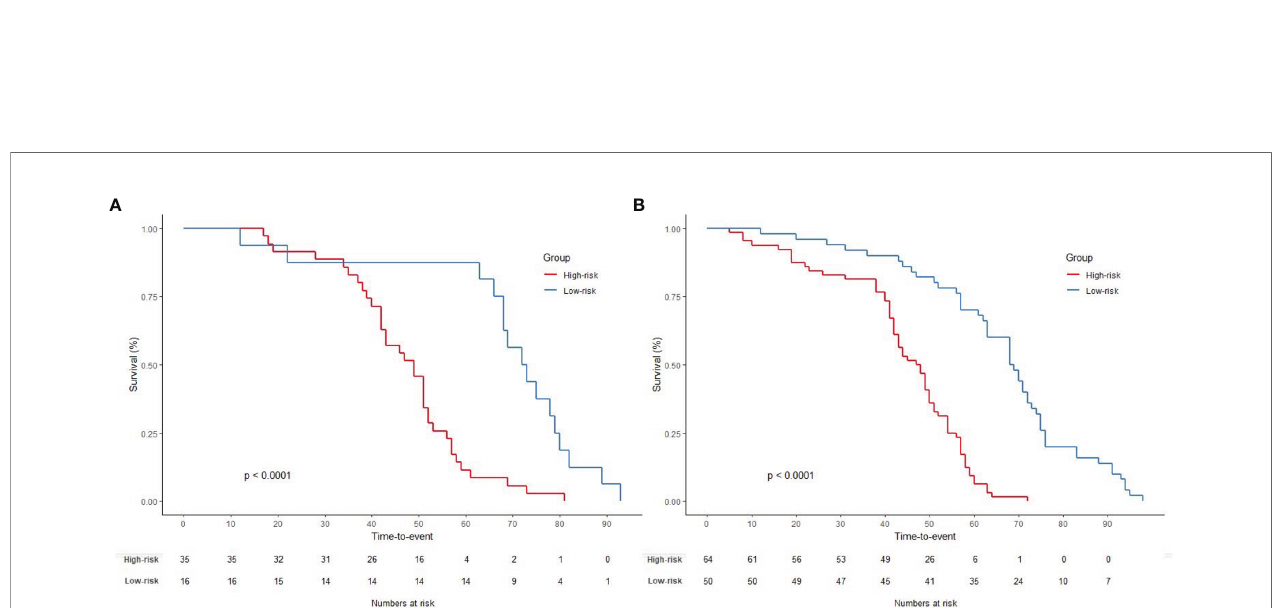
FIGURE 8 | Graphs show results of Kaplan – Meier survival analyses according to the radiomics signature for patients in (A) the primary data set (left) and those in (B) the test data set (right). A signi fi cant association of the radiomics signature with the OS was shown in the primary data set, which was then con fi rmed in the test data set.